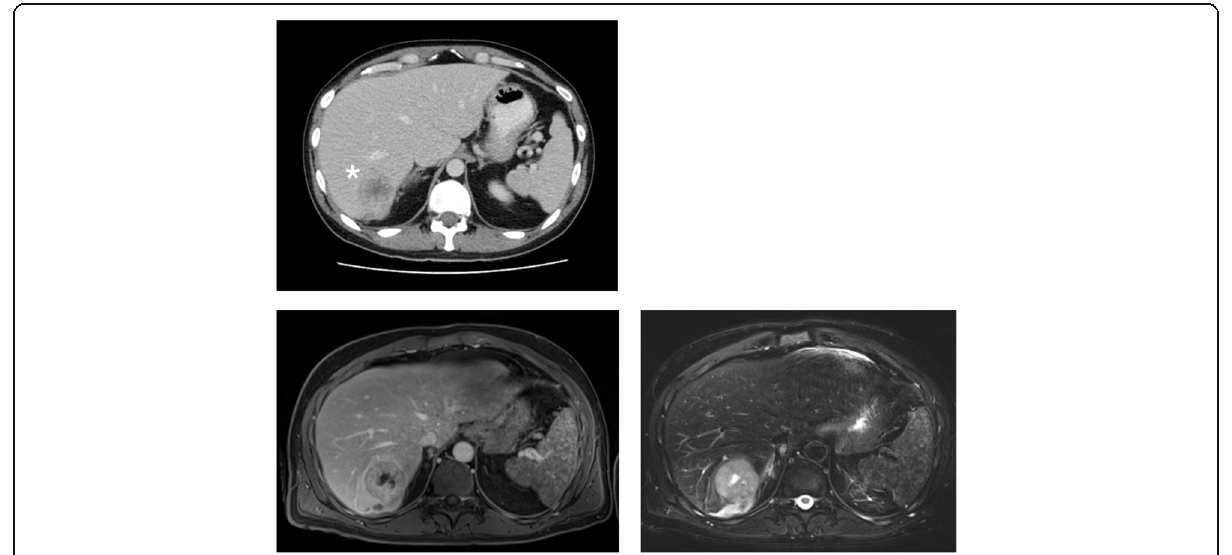
Fig. 1 The initial CT abdomen during the portal venous phase in axial reconstruction (upper left) shows a hypodense lesion (*) in liver segment VII. In the MRI examination, the lesion had hypointense signal in the T1 vibe Dixon sequence (lower row on the left) and a hyperintensive signal in the T2 blade fs (bottom row on the